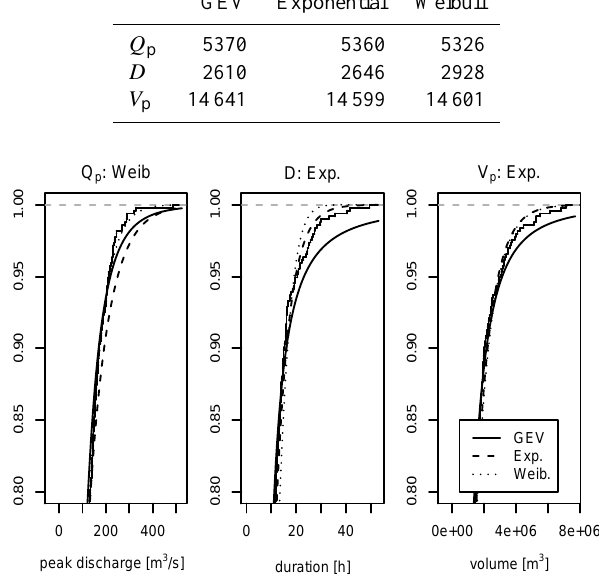
Fig. 3. The various cumulative distribution functions together with the empirical cumulative distribution function for the three vari- ables. The best fitting distribution is denoted in the title of each graph.